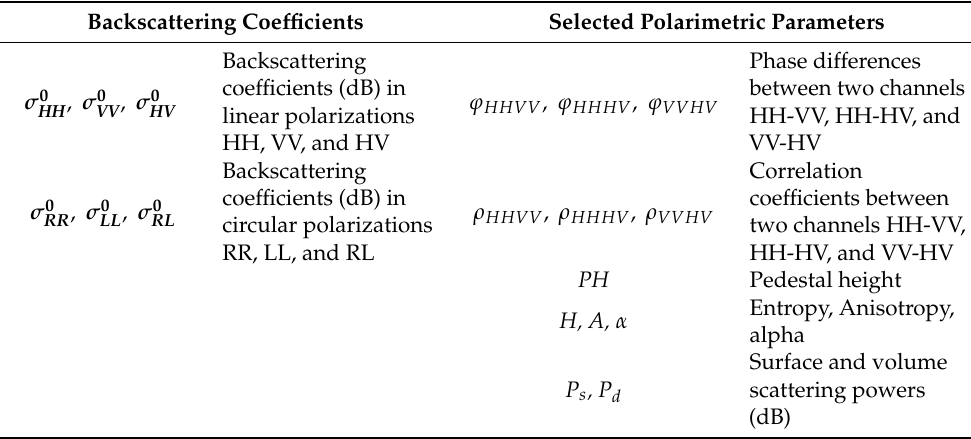
Table 1. Backscattering coefficients and selected polarimetric